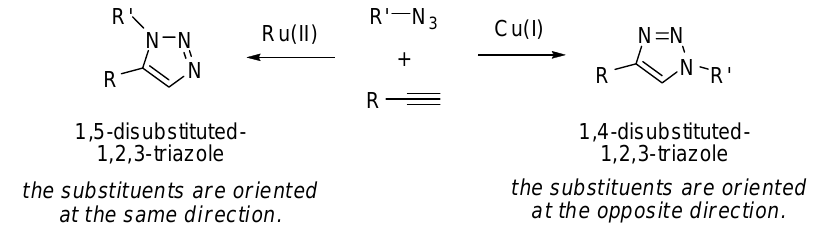
Figure 2 . Regioisomeric 1,2,3-triazoles synthesized by Huisgen